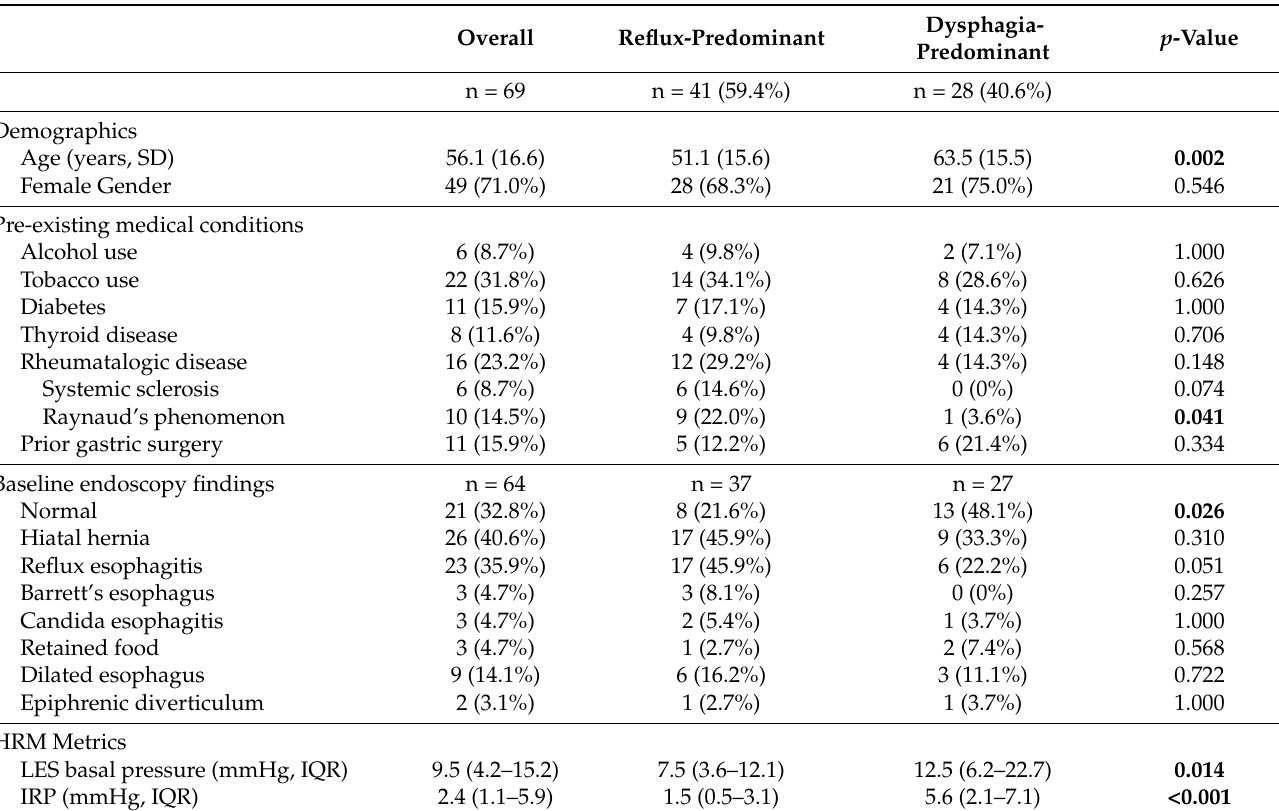
Table 1. Comparison between Reflux-predominant and Dysphagia-predominant Patients with Absent Contractility.